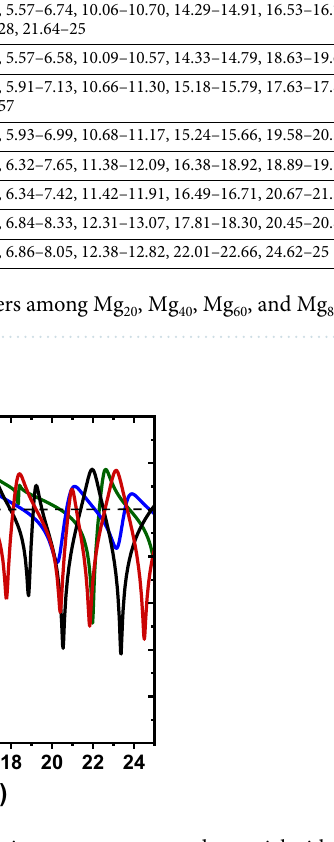
Figure 12. Comparison of transmission coefficients among proposed material with conventional materials.